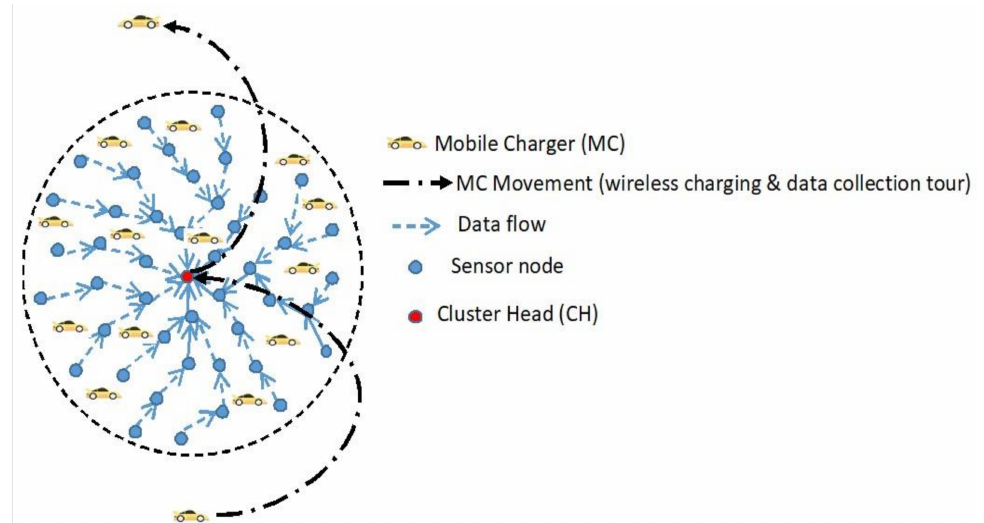
Figure 1. Network model and components.